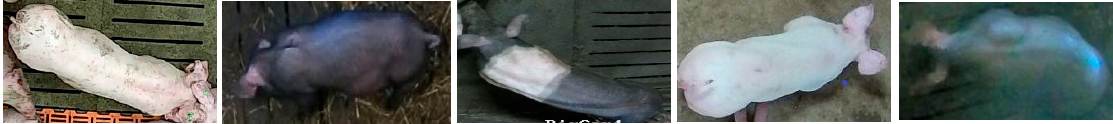
Figure 8. Sample of images of standing posture which are similar to belly lying posture in top view. Table 3. Confusion matrix of the proposed R-FCN ResNet101 in the test data set at learning rate of 0.003. Predicted Class Standing Lying on side Lying on belly Standing 1672 25 89 Actual class Lying on side 18 1382 31 Lying on belly 71 16 1523